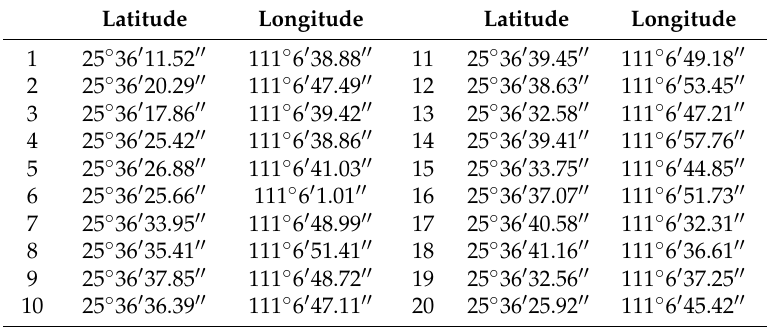
Table 25. Sample